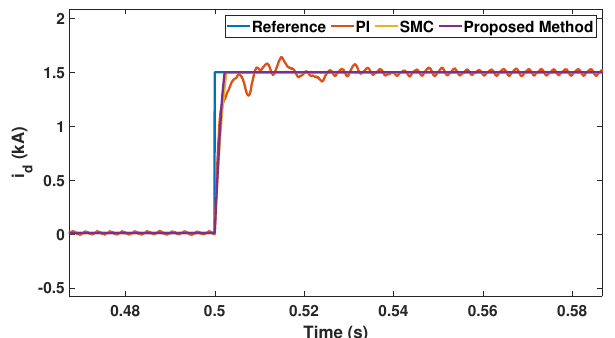
Figure 8. The trajectory of i d subjected to active current change.